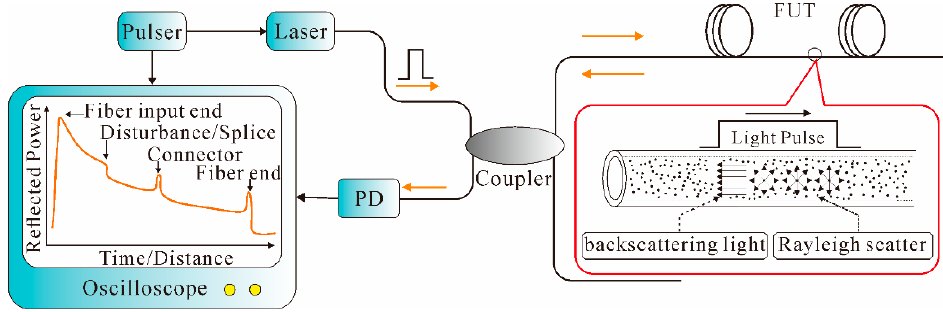
Figure 6. Typical OTDR setup and output waveform, adapted from Juarez [82].